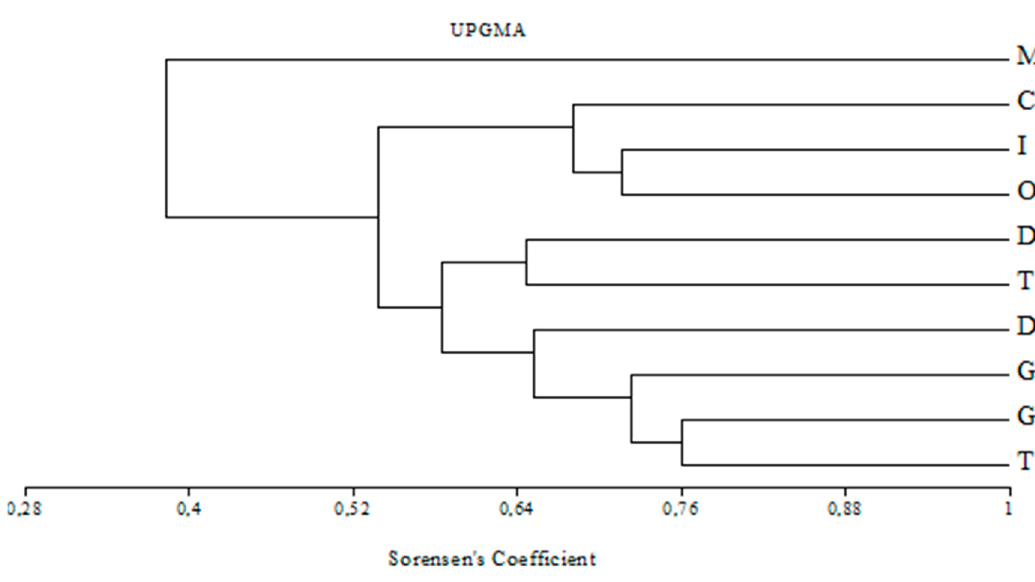
Figure 6. The results of the hierarchical cumulative classification using the average linkage method (UPGMA) of weed flora samples representing di ff erent types of land use due to the